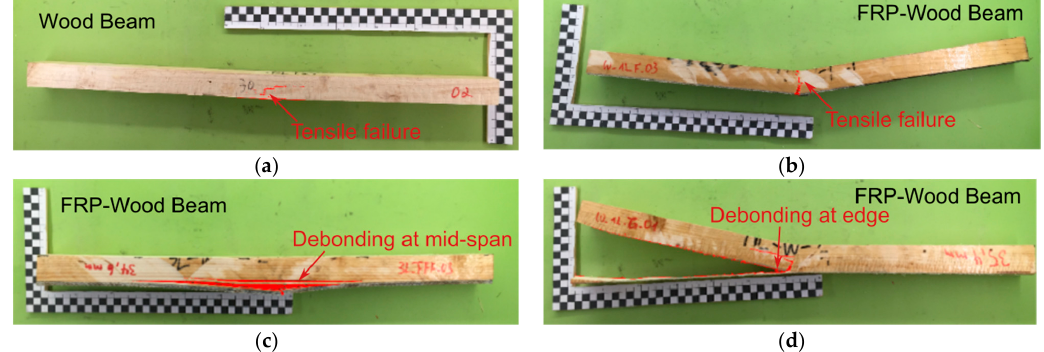
Figure 5. Typical failure modes of FRP–wood beams under three-point bending with different FRP laminates: ( a ) tensile failure for reference wood beam, ( b ) tensile failure (W_1L-F), ( c ) debonding at mid-span (W_3L-F) and ( d ) debonding at edge for FRP strengthened wood beam (W_1L-G).